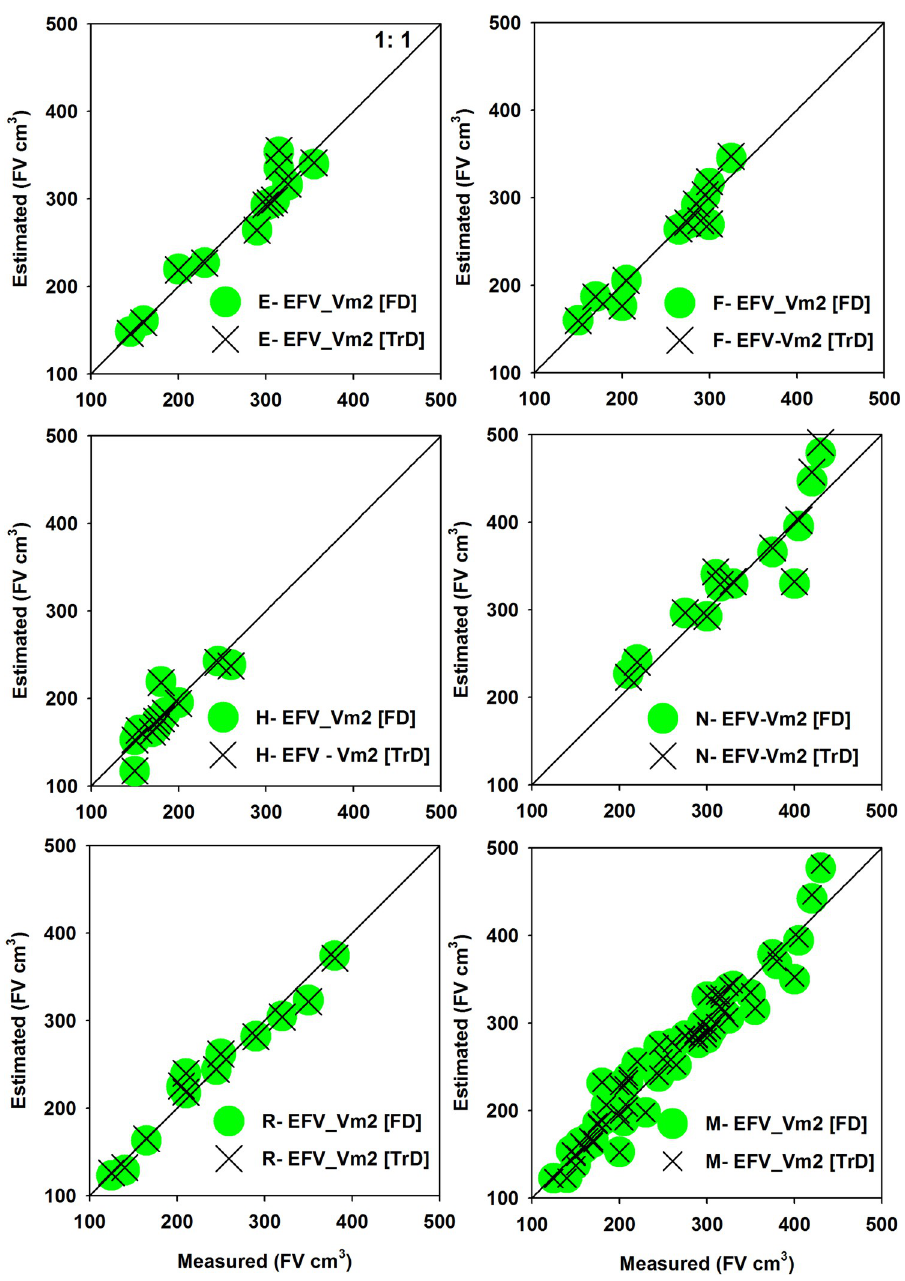
Fig 5. Relationship between estimated and measured fruit volume of the 12 cross-validation test fruits. Circles are the volume estimates calculated using the full data set equations and the crosses are the estimates calculated using the cross-validation training dataset equations. On Fig 5, the letter E, F, H, N, R and M refers Ettinger, Fuerte, Hass, Nabal, Reed and Mixed cultivar data.